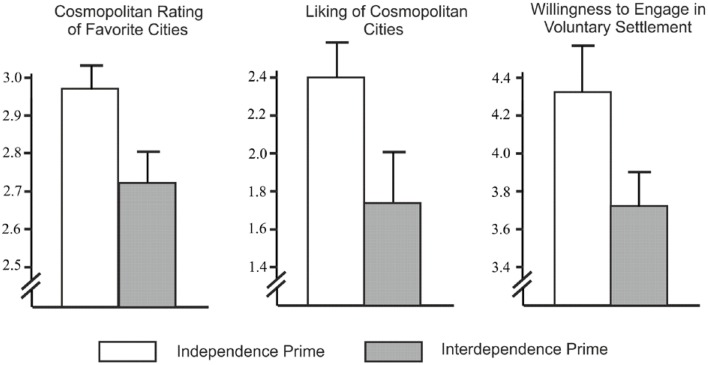
Study 2: Average cosmopolitanism rating (±SE) of participants' three favorite cities (left chart), liking for cosmopolitan relative to noncosmopolitan cities (middle chart), and willingness to engage in voluntary settlement (right chart) in different priming conditions (independence vs. interdependence).